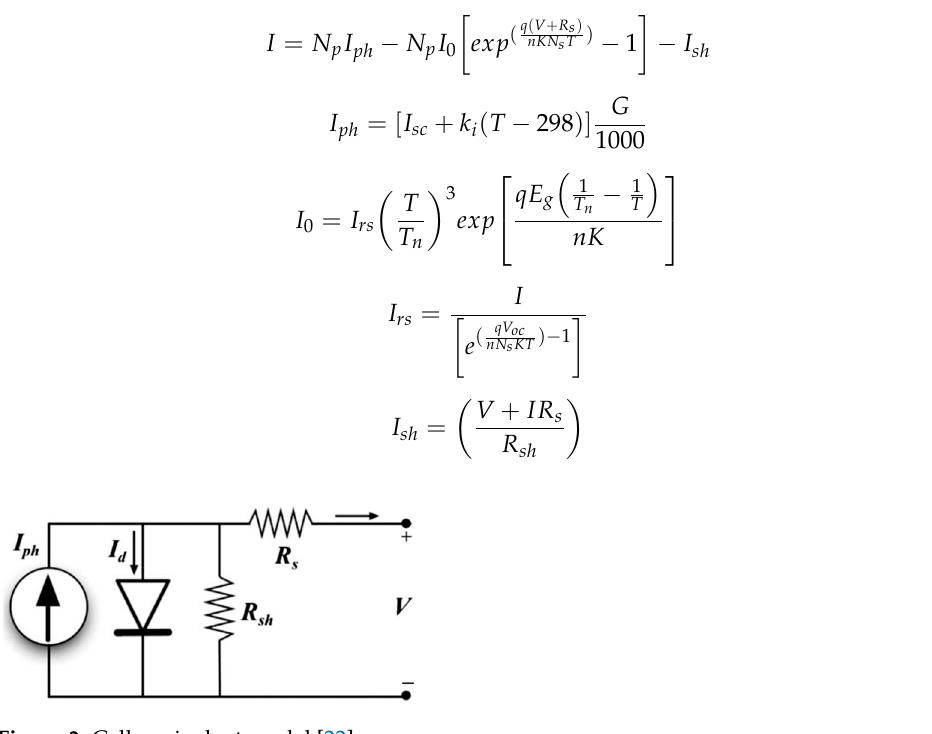
Figure 2. Final assembled miniature tracking system.